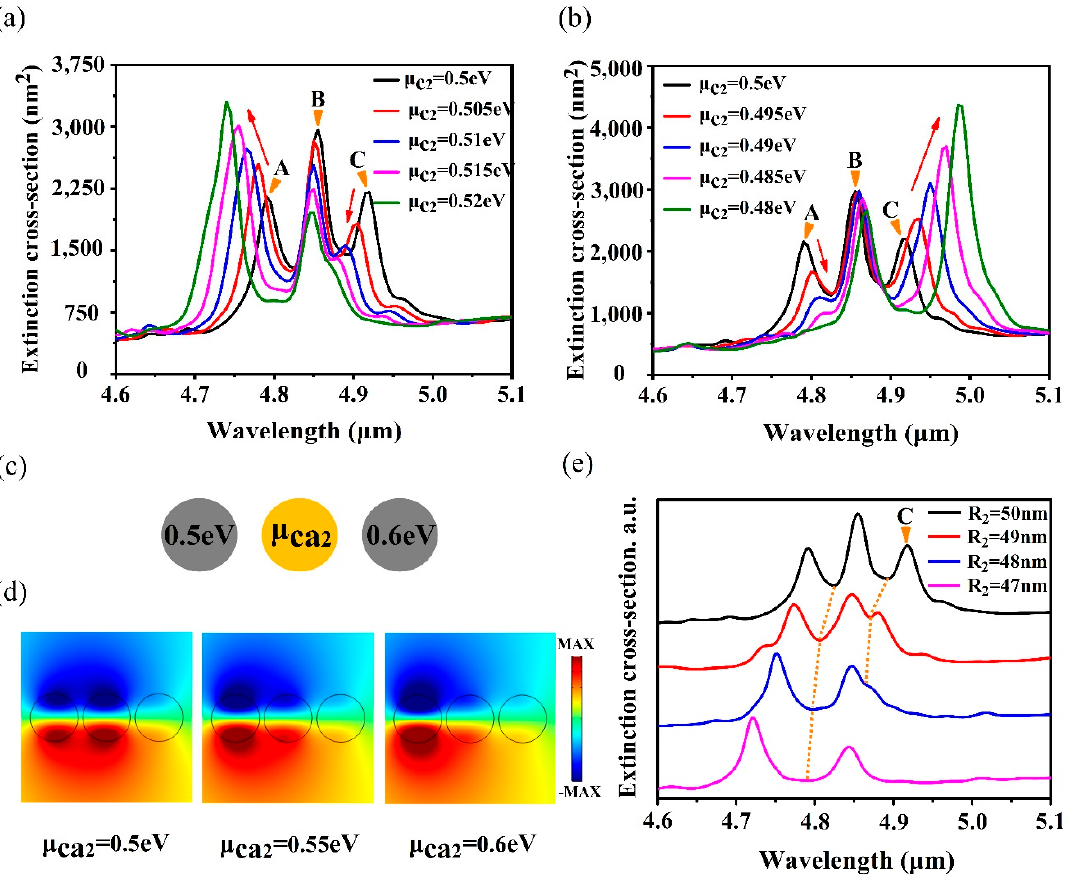
Figure 4. ( a ) Extinction spectra with the adjustment of µ c 2 from 0.5 eV to 0.52 eV. ( b ) Extinction spectra with the variation of µ c 2 from 0.48 eV to 0.5 eV. ( c ) The distribution of the chemical potential in the trimer. Figure 4 ( a ) Extinction spectra with the adjustment of 𝜇 (cid:3030)(cid:2870) from 0.5 eV to 0.52 eV. ( b ) Extinction ( d ) The near-field distributions with di ff erent µ ca 2 . ( e ) The influence of the radius of the intermediate spectra with the variation of 𝜇 (cid:3030)(cid:2870) from 0.48 eV to 0.5 eV. ( c ) The distribution of the chemical potential ring nanodiscs on FR in the trimer. ( d ) The near-field distributions with different 𝜇 (cid:3030)(cid:3028)(cid:2870) . ( e ) The influence of the radius of the intermediate ring nanodiscs on FR modes.